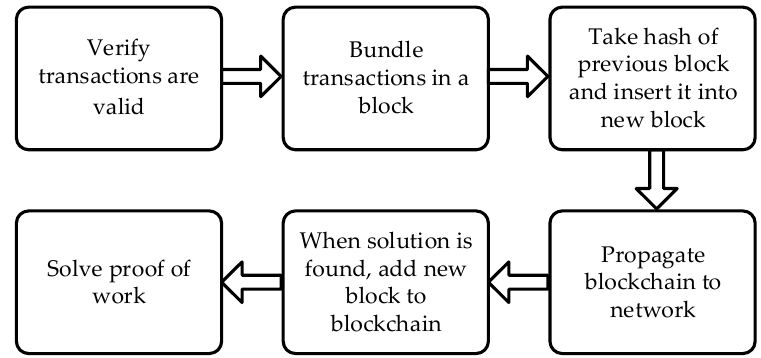
Figure 1. Bitcoin mining process using blockchain technology.